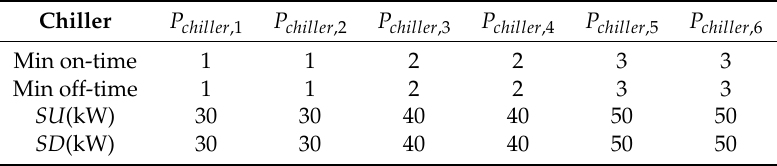
Table 2. Operational constraints for chillers 1 to